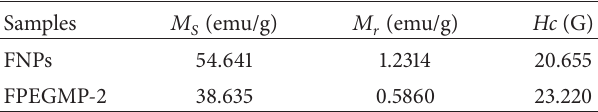
Table 1: Magnetic properties of FNPs and FPEGMP-2 nanocom-